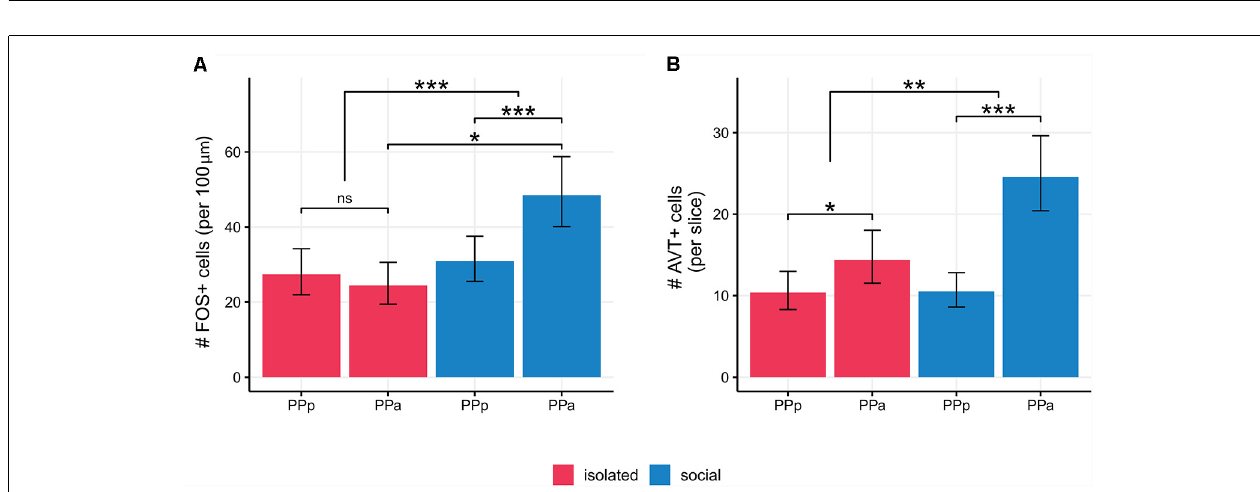
FIGURE 4 | (A) Social males show higher number of FOS+ cells/100 µ m 2 in PPa sections with respect to PPp ones ( p < 0.001) and as compared to PPa sections in isolated males ( p = 0.02). (B) Isolated males show a higher number of AVT+ cells in PPa sections compared to PPp sections. ( p = 0.01). Social males also show a higher number of AVT+ cells in PPa sections compared to PPp section ( p < 0.001). The difference between PPa and PPp cell AVT+ cells was larger for social males ( p = 0.003). POA, preoptic area; PPa, nucleus preopticus ventricularis, anterior subdivision; PPp, nucleus preopticus ventricularis, posterior subdivision. ∗ p < 0.05, ∗∗ p < 0.01, ∗∗∗ p < 0.001; ns, non-significant.